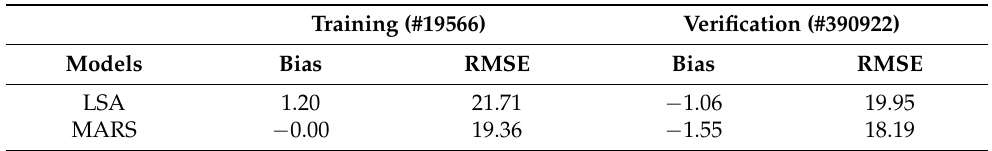
Table A4. Bias and root mean square error of LSA-SAF and MARS for the training and verification samples (#) in cloudy-sky conditions. Units are in W · m − 2